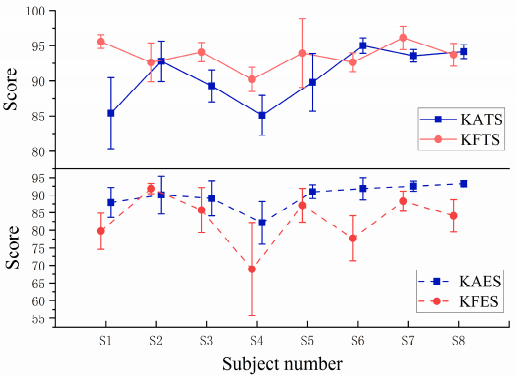
Figure 18. Graph of the mean scores of the eight subjects at different stages. The top half of the image shows the comparison of mean scores during the training stage and the bottom half of the image shows the comparison of mean scores during the evaluation stage.